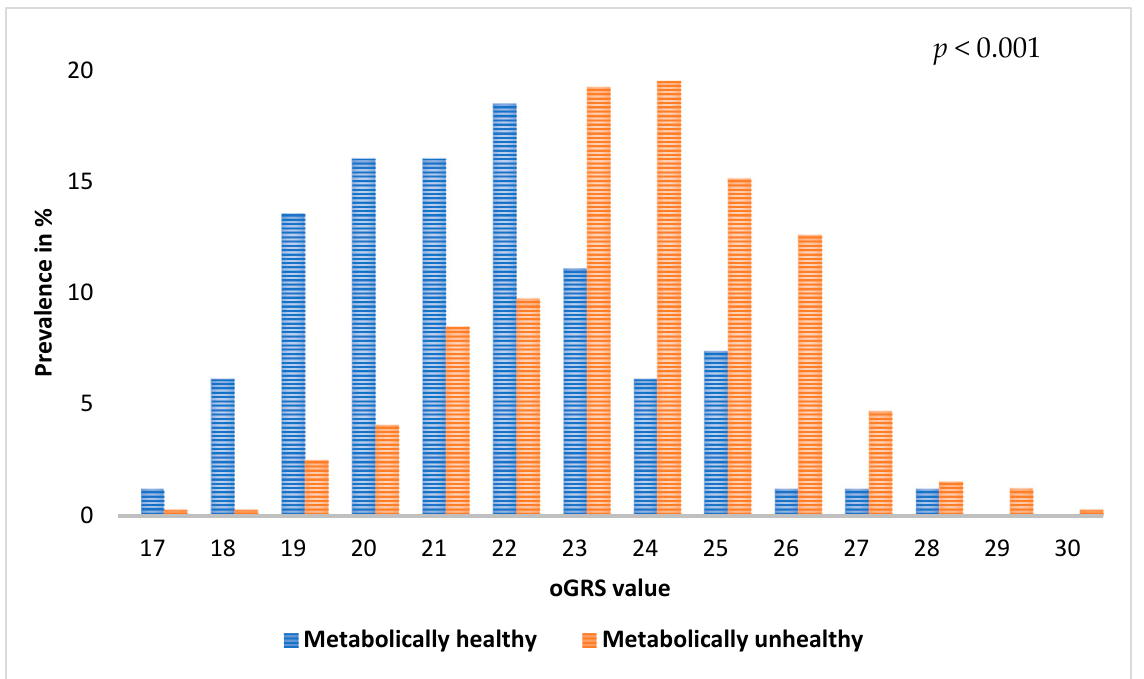
Figure 1. Comparison of the distribution of optimized genetic risk scores (oGRS) in metabolically healthy and unhealthy obese individuals. The genetic risk score was optimized for metabolically unhealthy obesity based on 19 single nucleotide polymorphisms (selected in the GRS optimization process).